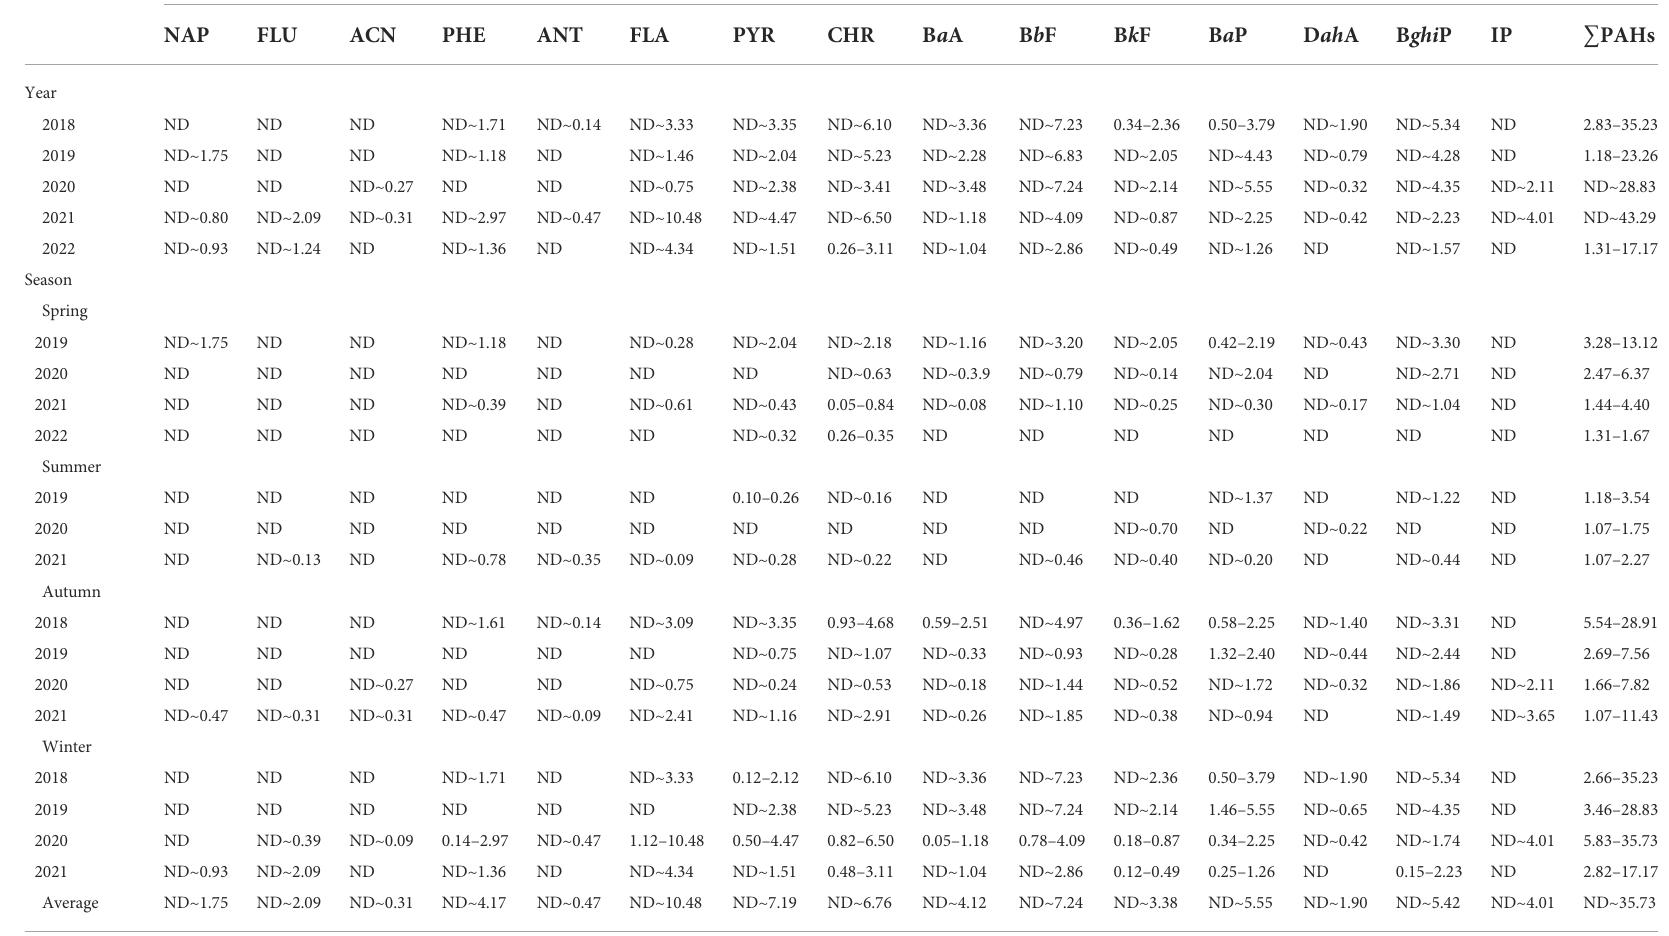
TABLE 1 Total concentration range of PAHs in PM 2.5 during the study period from 2018 to 2022 (ng/m 3 ).